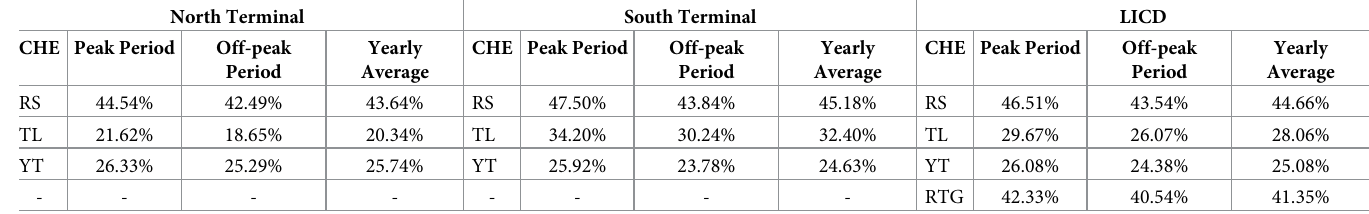
Table 12. Simulation results for scenario S5.